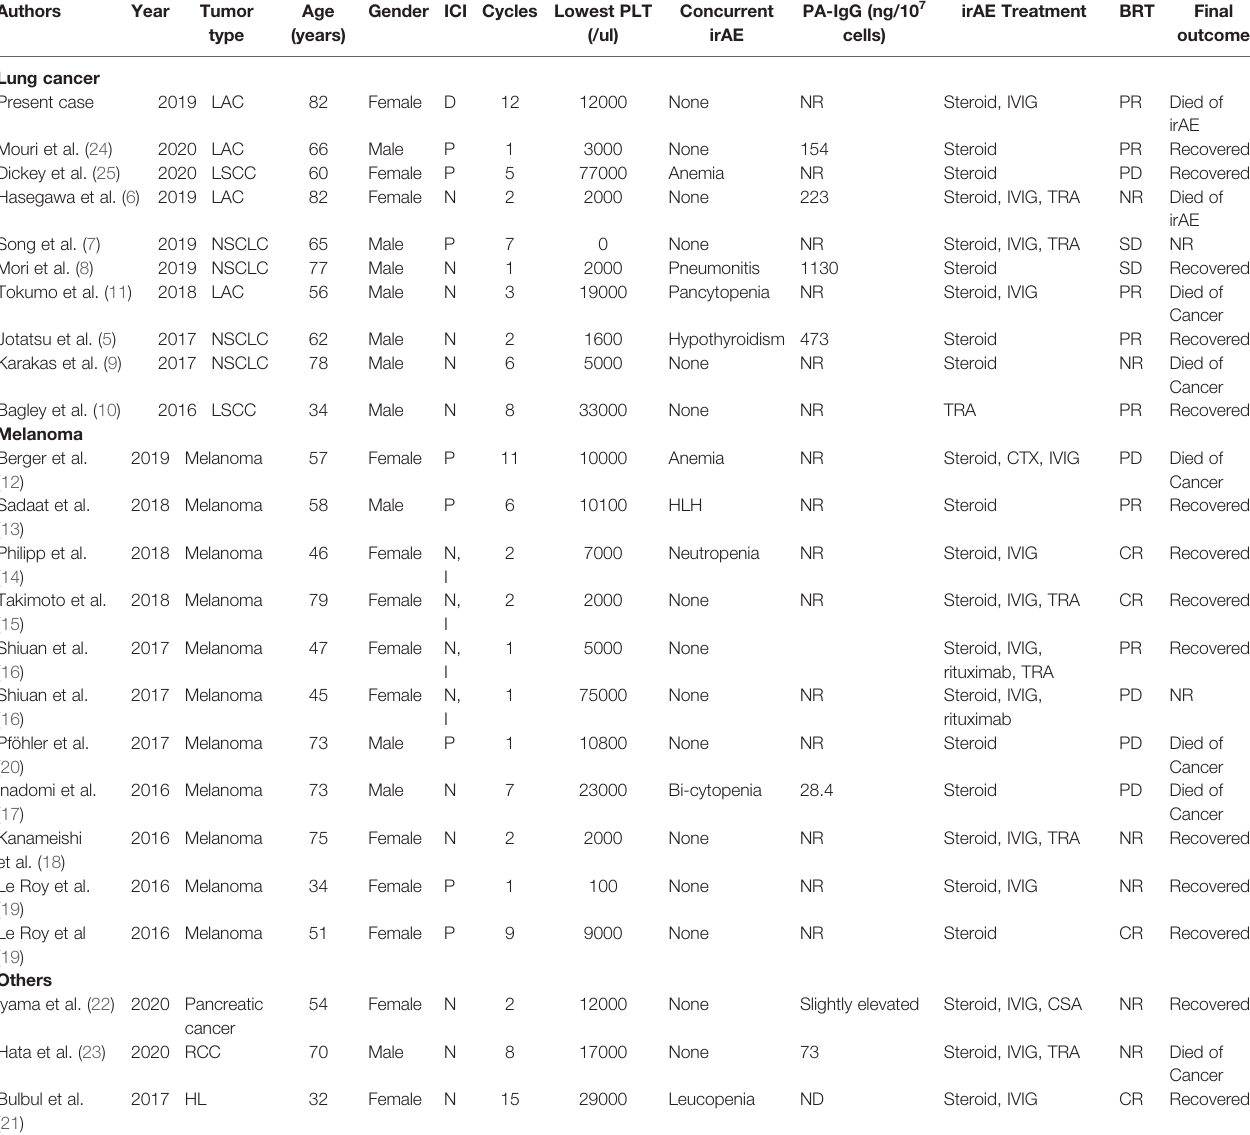
TABLE 1 | Summary of reported cases with immune-related thrombocytopenia after receiving